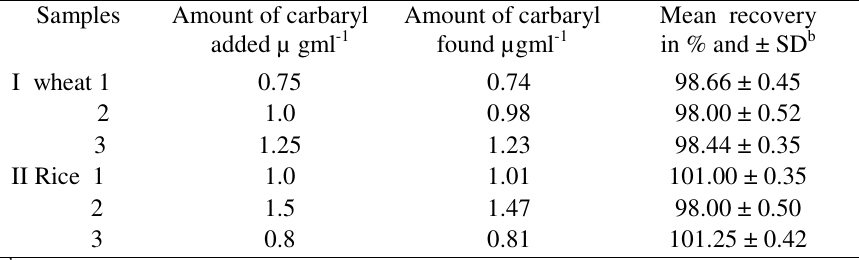
Table 5 . Comparison of Other Spectrophotometric methods with proposed method